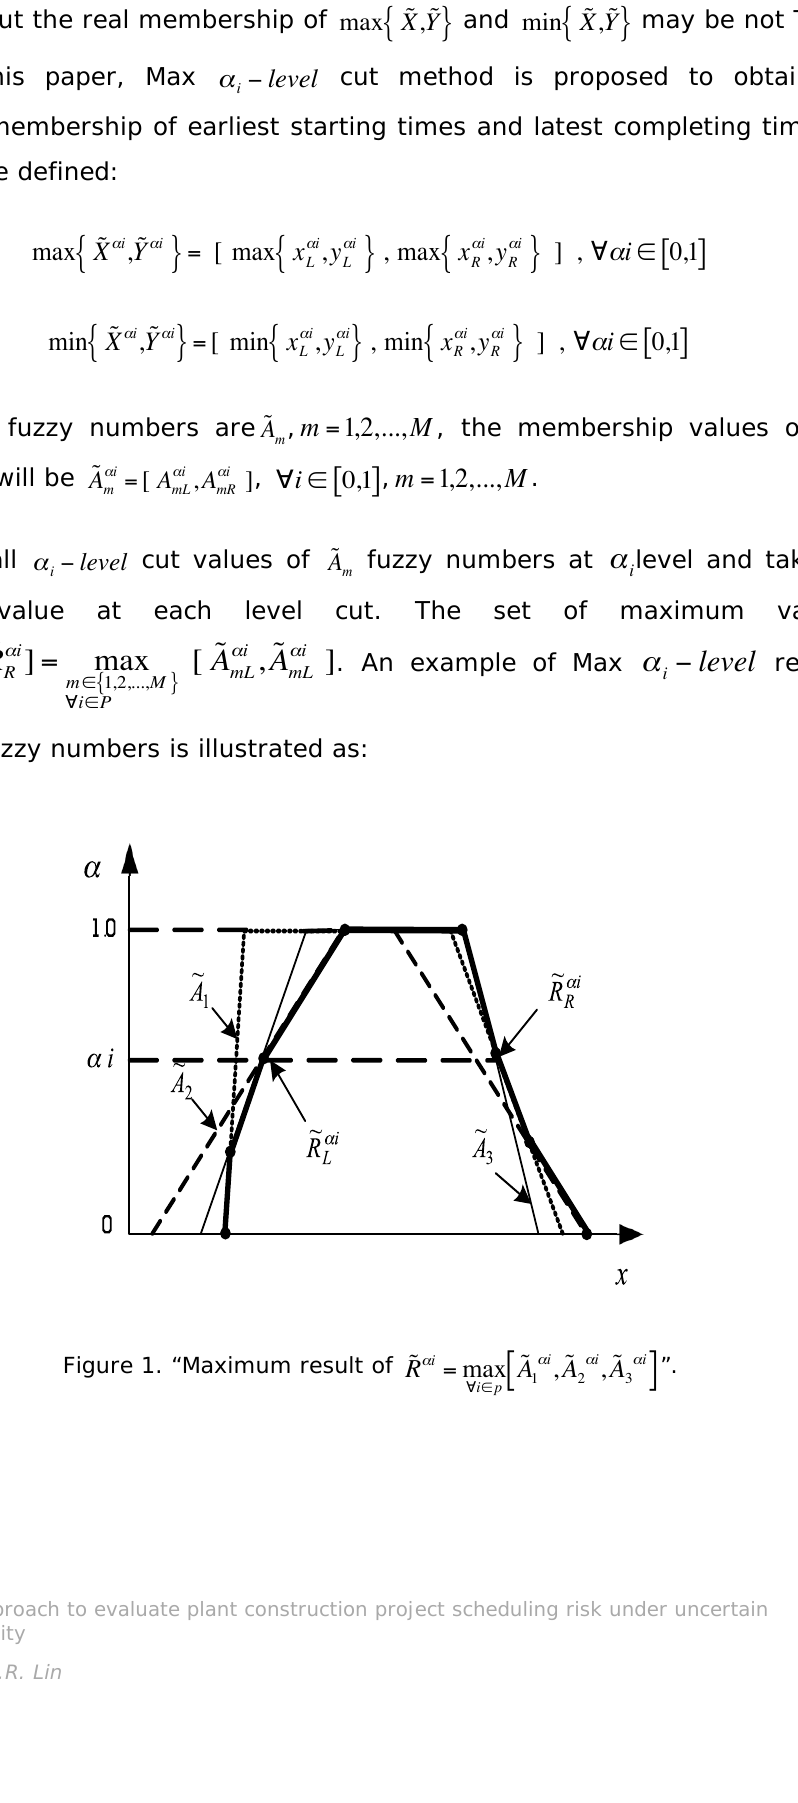
˜ A (cid:2) i , ˜ A (cid:2) i , ˜ A (cid:2) i [ ] 1 2 3 (cid:3) i (cid:1) p